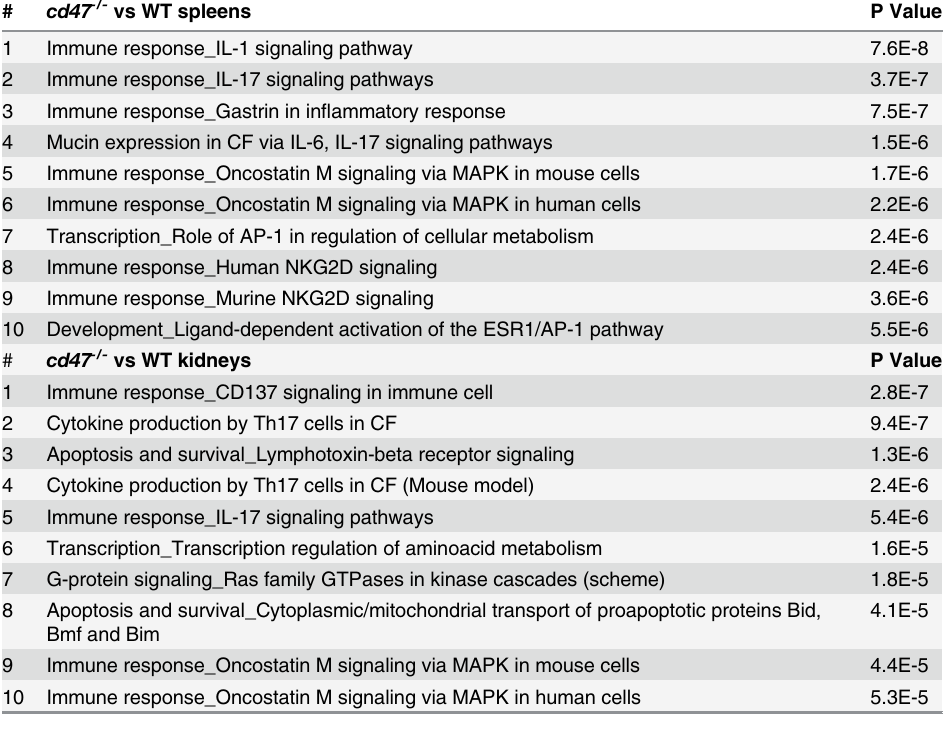
Statistics are listed for the top ten statistically signi fi cant maps based on differential gene expression in cd47 -/- versus WT spleens and kidneys generated by MetaCore